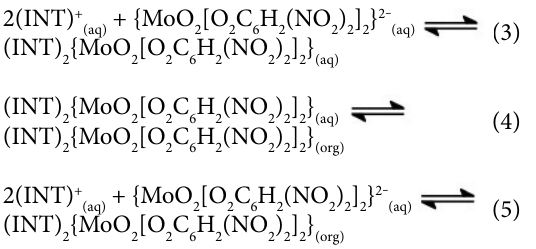
Figure 6. Dependency of ( C.l/A ) on A ‒n/(n+1) (method of Komar– Tolmachev) C = C ; C = 2 C ; C = 2.0 × 10 ‒4 M; Mо(VI) INT Mo(VI) 3,5-DNC A – absorbance; l – cell thickness, l = 1 cm; n =